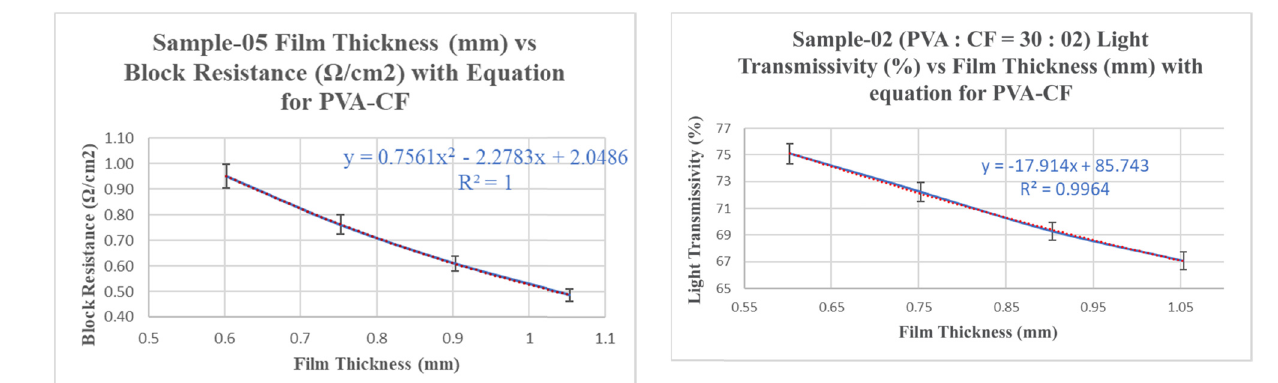
Figure 17: Sample - 02 ( CF:PVA = 0.2:30 ) light transmittance ( % ) versus fi lm thickness ( mm ) with equation for PVA - CF. The dotted lines represent the polynomial fi tted curve and the linear fi tted.